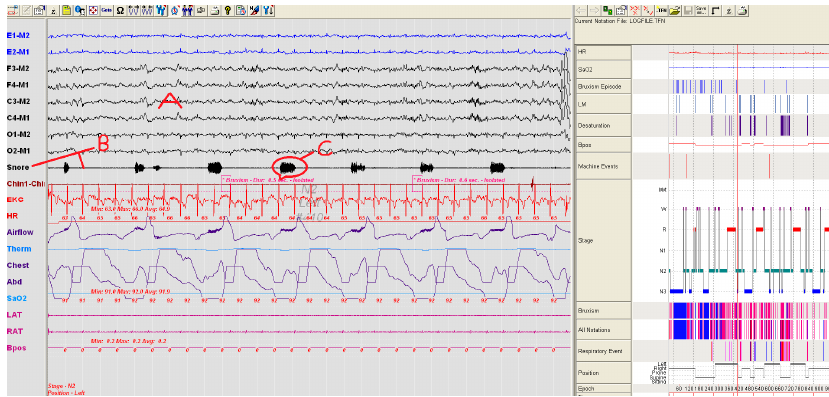
Figure 7. A patient sample not using SNORAP—high volume snoring sounds are observed in the snore line (A: 6-channel EEG, B: Snoring trace, C: high amplitude snoring packets).